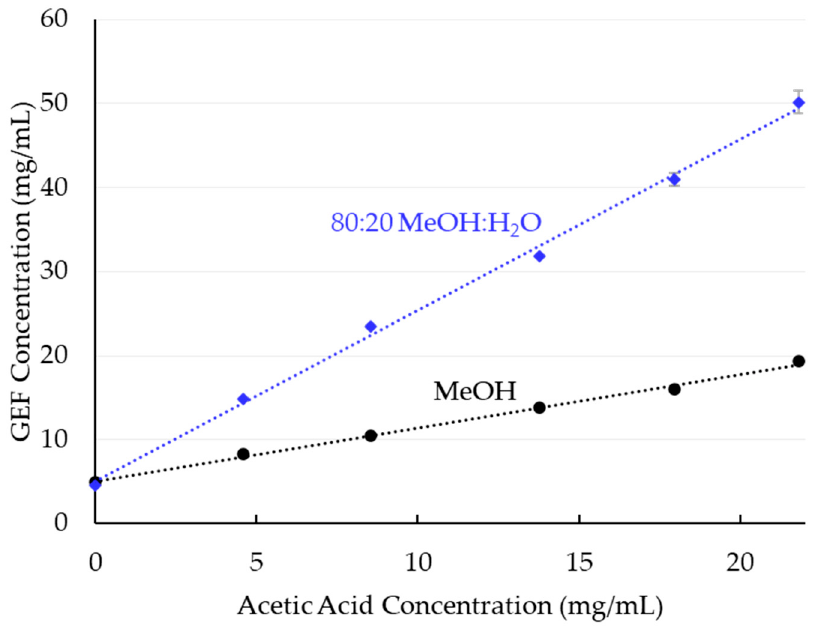
Figure 2. Solubility of GEF in MeOH and 80:20 MeOH:H 2 O as a function of acetic acid concentration.